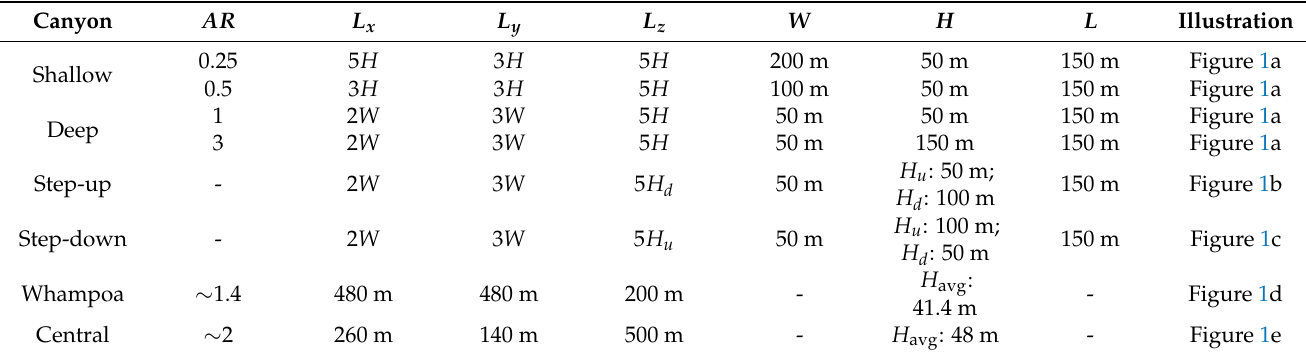
Figure 1. Urban geometries and vortex sheets ( a ) shallow or deep canyon; ( b ) step-up canyon; ( c ) step-down canyon; ( d ) homogeneous neighbourhood (Whampoa, Hong Kong); ( e ) heterogeneous t neighbourhood (Central, Hong Kong). The vortex sheets are indicated in colour: roof level, (cid:60) b (yellow); intermediate, i (red); sidewall, s (green). There are several (violet); ground level, (cid:60) (cid:60) (cid:60) i k and s k , for the asymmetric and realistic intermediate and sidewall vortex sheets, denoted as (cid:60) (cid:60) canyons. Computational domain parameters are described in Table 1. Table 1. Computational domain parameters. L x , L y , L z denote the domain dimensions; H , W , L are the building dimensions. For more complicated domains, H u is the height of upstream building, H d is the height of the downstream building and H avg is the mean building